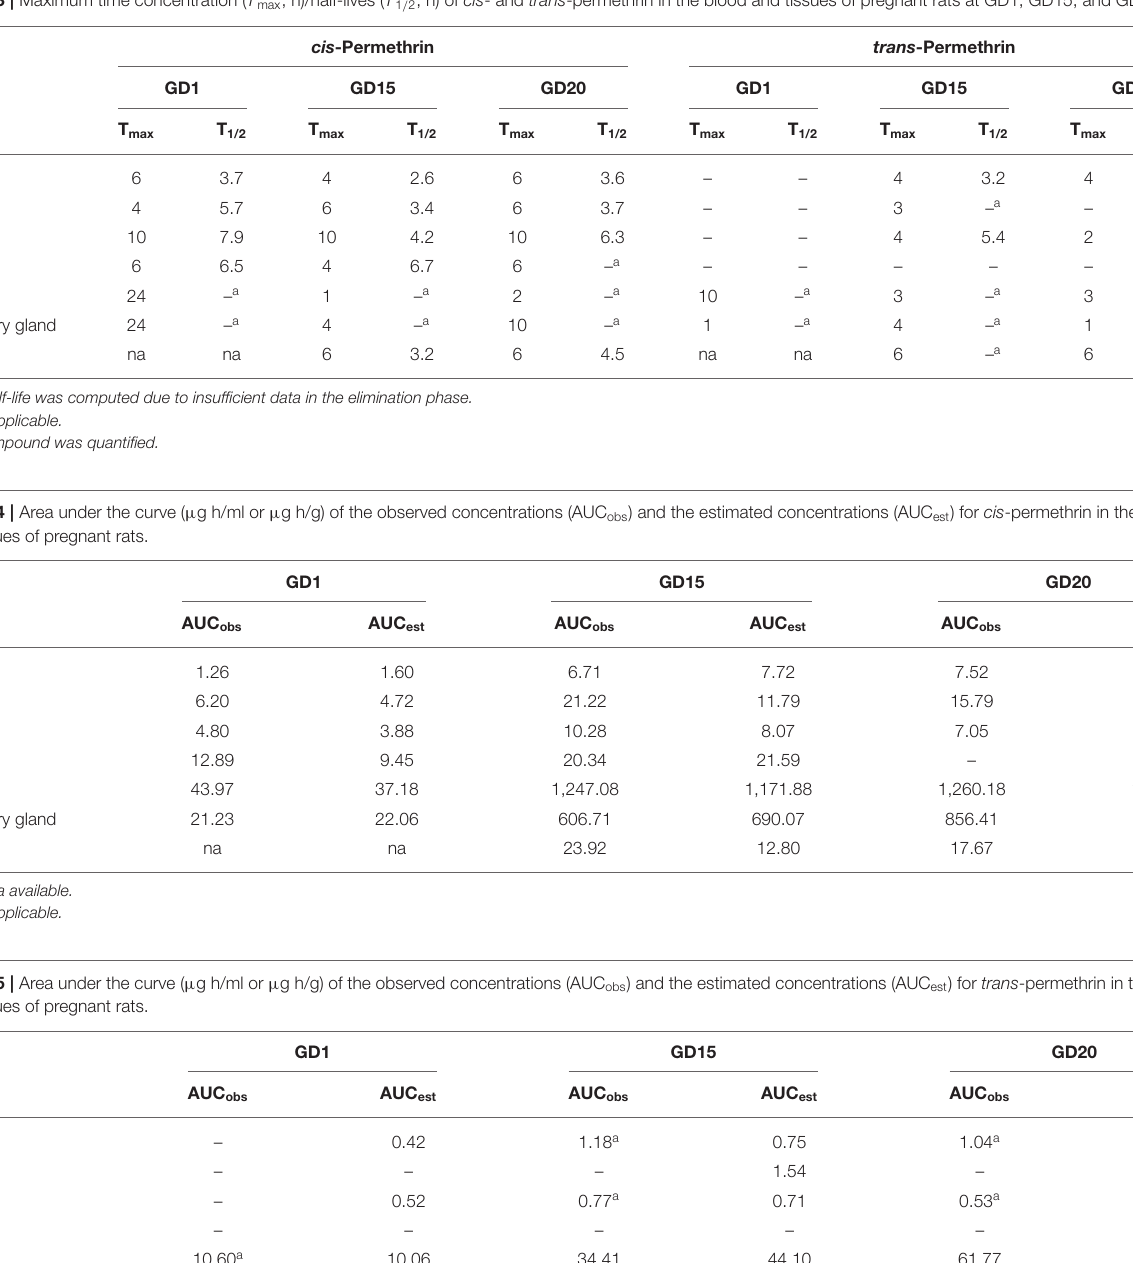
TABLE 3 | Maximum time concentration ( T max , h)/half-lives ( T 1 / 2 , h) of cis - and trans -permethrin in the blood and tissues of pregnant rats at GD1, GD15, and GD20.